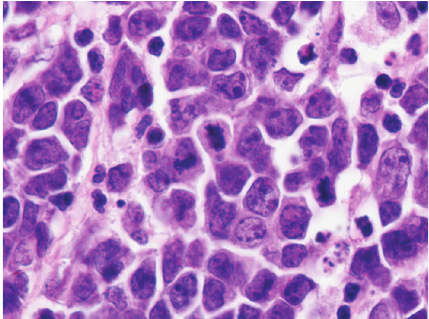
Figure 4: The lymphoma cells are squared off. Mitotic figures and apoptotic bodies are evident (H & E stain, × 1000 magnification with